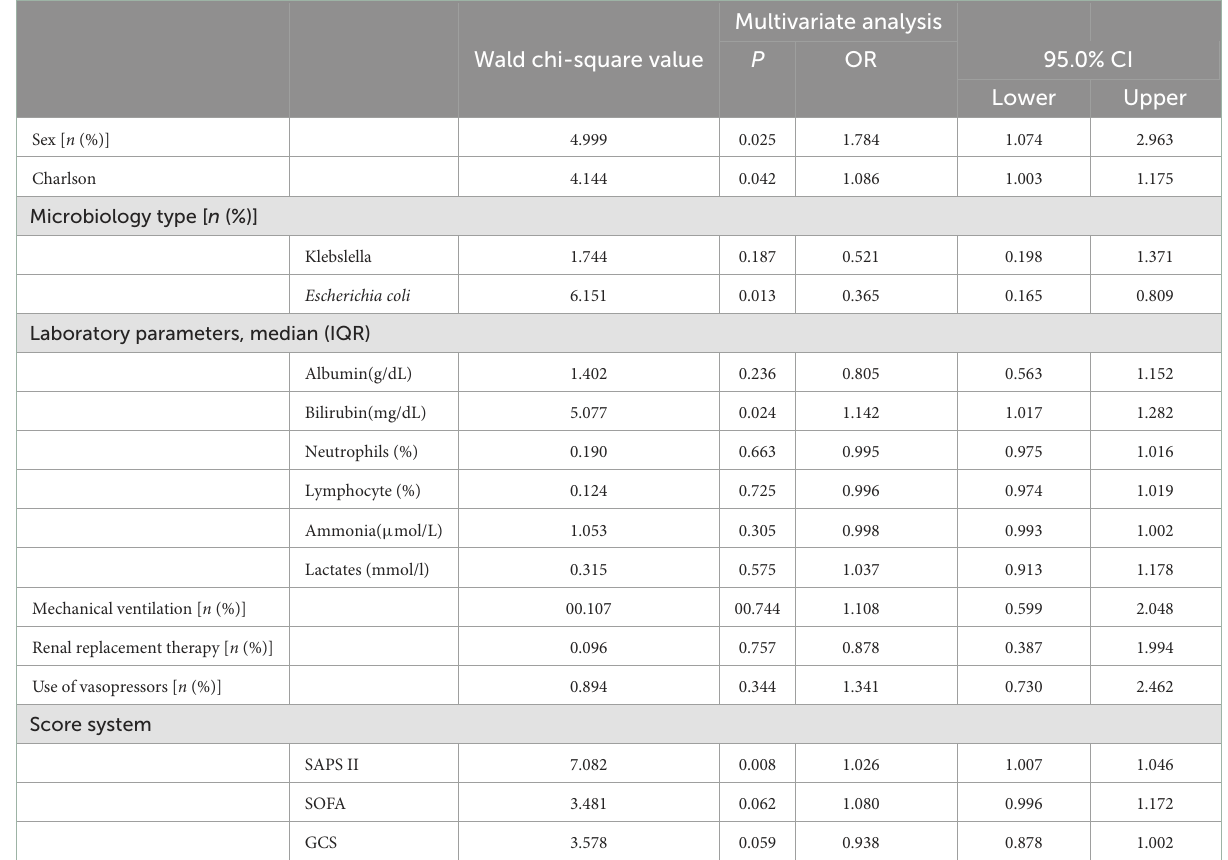
TABLE 2 Multivariate logstic regression analysis of hospital mortality in SAE